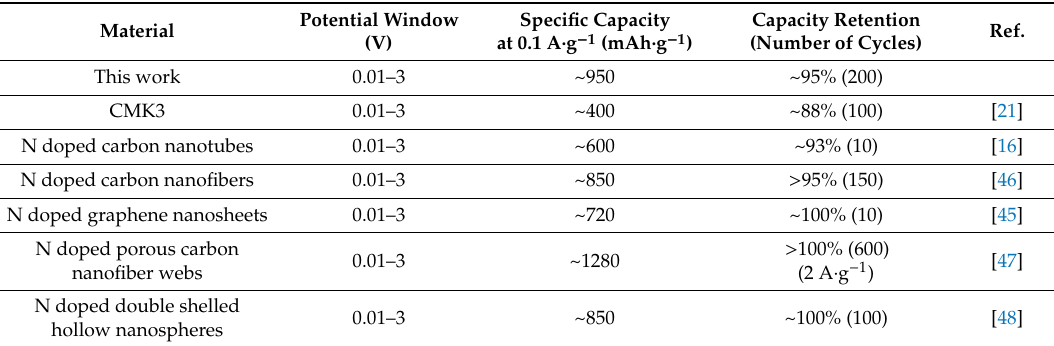
Figure 4. Voltage profiles for the first 3 cycles of ( a ) N-CMK-8 and ( b ) CMK-8. Long-term specific capacities of ( c ) N-CMK-8 and ( d ) CMK-8.